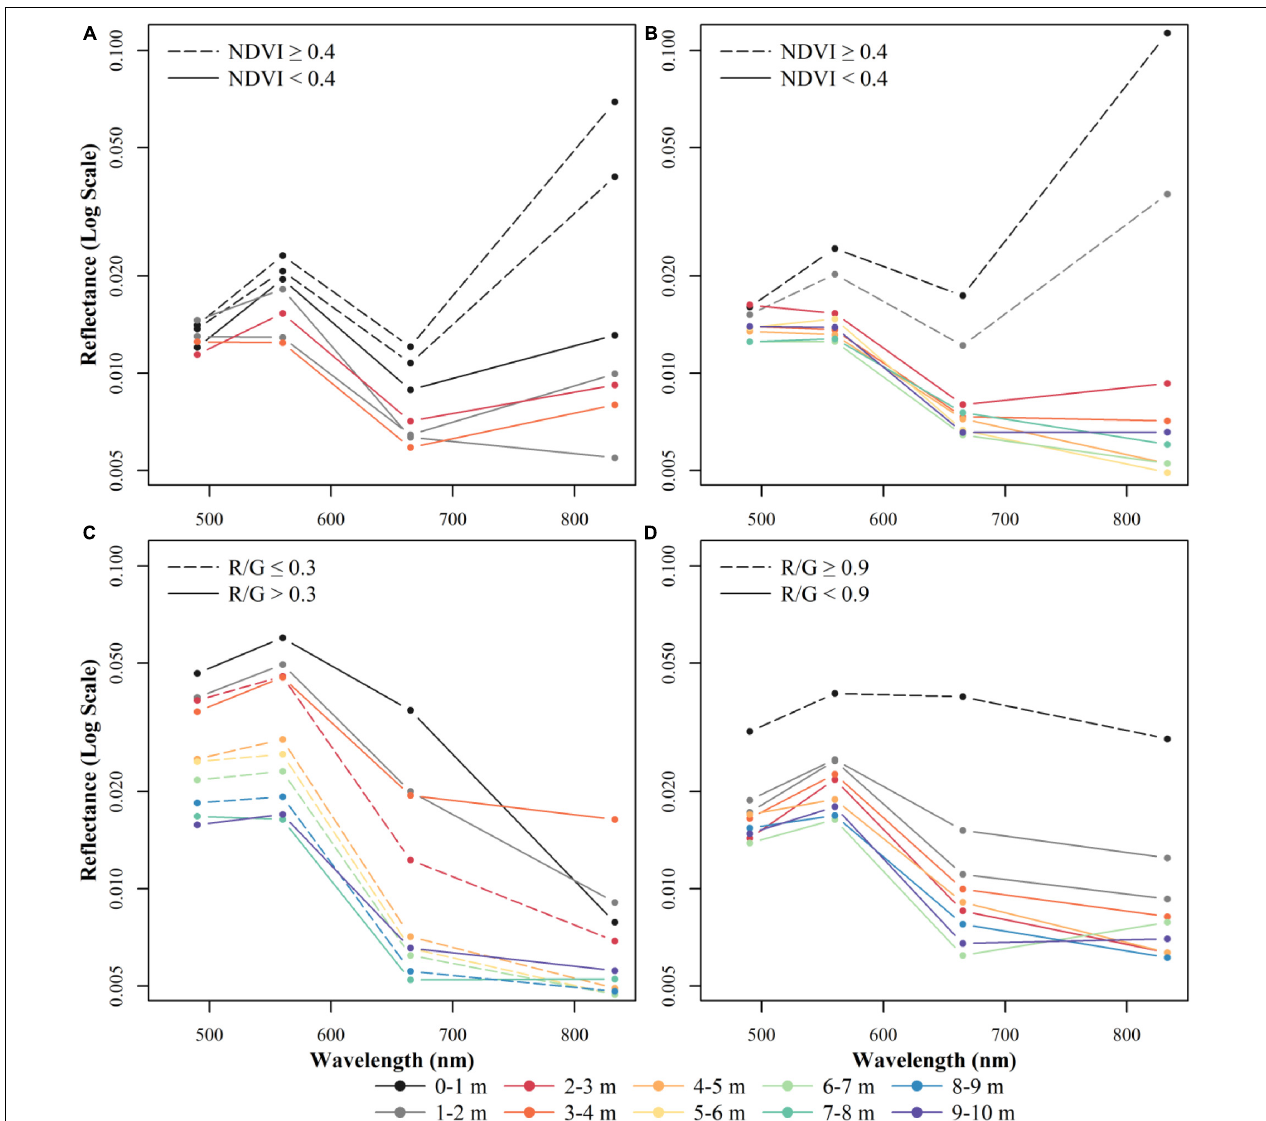
FIGURE 3 | Example spectra from representative field survey points across multiple depths for (A) eelgrass, (B) seaweed, (C) sand, (D) mud. Dashed lines indicate pixels that would be classified using the NDVI or R/G band thresholds. Solid lines indicate pixels classified with the random forests model. Note that seaweed at 0–3 m, mud at 0–1 m, and sand at 1–2, 4–7, and 8–9 m of depth is based on visually identified points. No non-patchy eelgrass habitat was sampled at > 4 m water depths and visually identified points at these depths could not be labeled with certainty to be an eelgrass bed (instead of a seaweed dominated